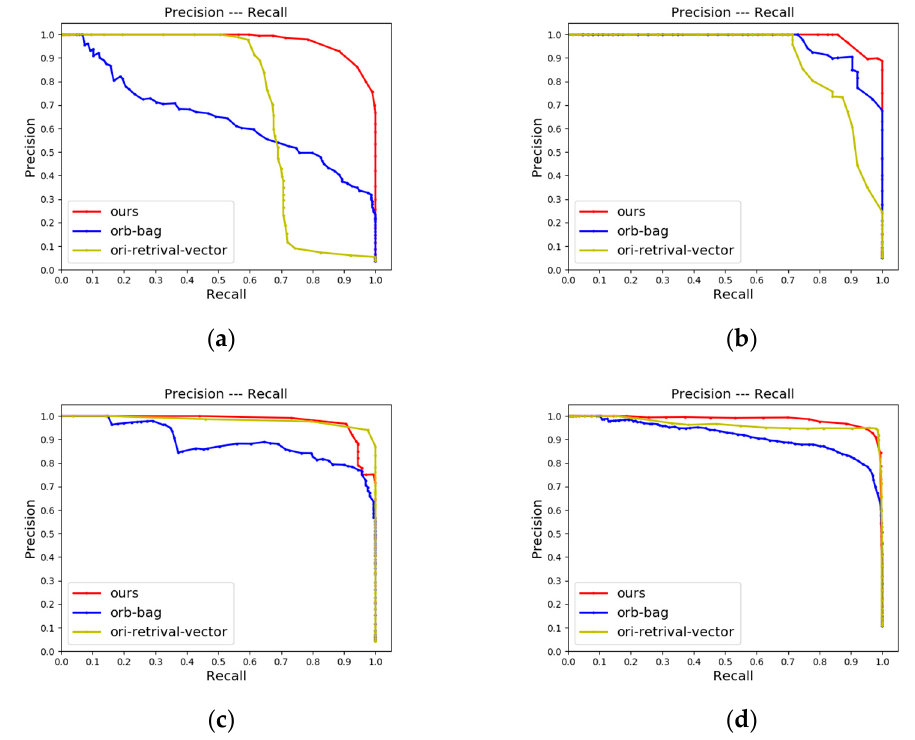
Figure 14. P-R curves of CMCD, orb-bag, and ori-retrieval-vector on JLU datasets: ( a ) The P-R curve of jlu00; ( b ) The P-R curve of jlu01; ( c ) The P-R curve of jlu02; ( d ) The P-R curve of jlu03.